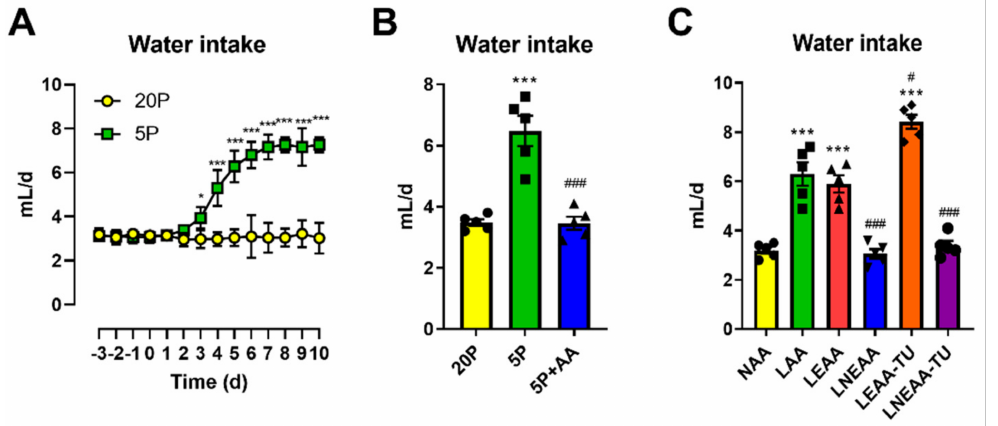
Figure 1. Dietary restriction of essential-, but not non-essential-, -amino acids is sufficient and required for the hyperdipsic response to dietary protein dilution. ( A ): Time-course effect of dietary protein dilution on water intake. Both groups were fed a control diet (20P) leading up to the diet switch, where one group was switched (time 0) to a protein dilute diet (5P) with water intake measured throughout. Data are mean and SEM; n = 8 per group. Different than 20P: * p < 0.05, *** p < 0.001. ( B ): Water intake rate of mice kept on diets with 20% energy from protein (20P), 5% energy from protein (5P), or 5% energy from protein and 15% energy from amino acids (AA) to match 20P. Data are mean ± SEM; n = 5 per group. Different than 20P: *** p < 0.001. Different than 5P: ### p < 0.001. ( C ): Water intake in mice fed diets containing 18% AA (normal AA; NAA), 4.5% AA (low AA; LAA), low essential AA (EAA) with normal non-EAA (LEAA), low non-EAA with normal EAA (LNEAA), LEAA with NEAA topped up to reach total AA of that in NAA (LEAA-TU), and LNEAA with EAA topped up to reach total AA of that in NAA (LNEAA-TU). Data are mean ± SEM; n = 5 per group. Different than 20P: *** p < 0.001. Different than 5P: # p < 0.05, ### p < 0.001. Statistical analyses: Two-way repeated measures ANOVA ( A ), one-way ANOVA ( B , C